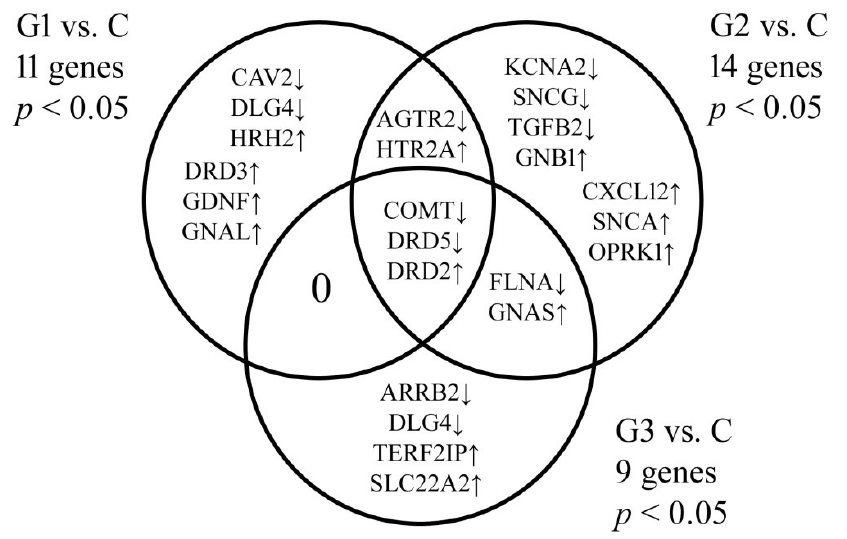
Figure 1. Venn diagram showing dopamine-related genes differentiating endometrial cancer from control. C, control, and G, endometrial cancer grade. p < 0.05 vs. C group.